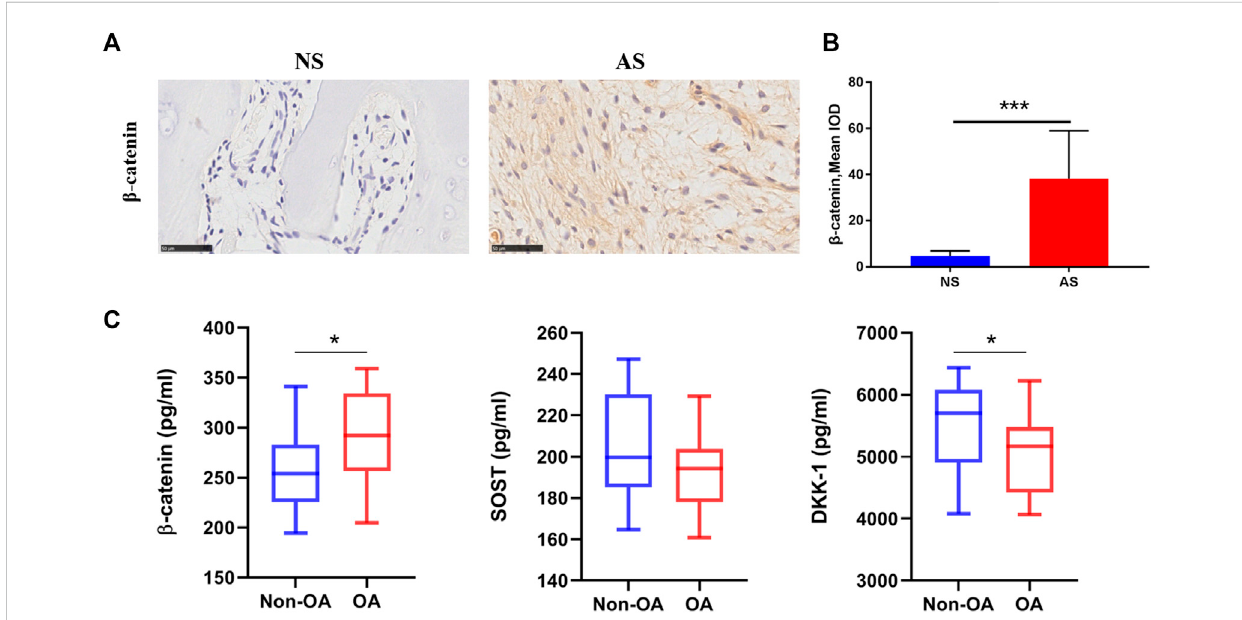
FIGURE 5 Wnt-related protein expression in clinical samples. (A) Representative images of β -catenin expression in tibial plateau samples from the NS and AS groups.Scalebarsrepresent500 μ m. (B) Semi-quantitative analysis ofthe β -catenin expressionintheNSandASgroups. (C) β -Catenin, SOST,andDKK-1 serum concentrations in patients with and without osteoarthritis. NS, less damaged subchondral bone; AS, severely damaged subchondral bone; IOD, integrated optical